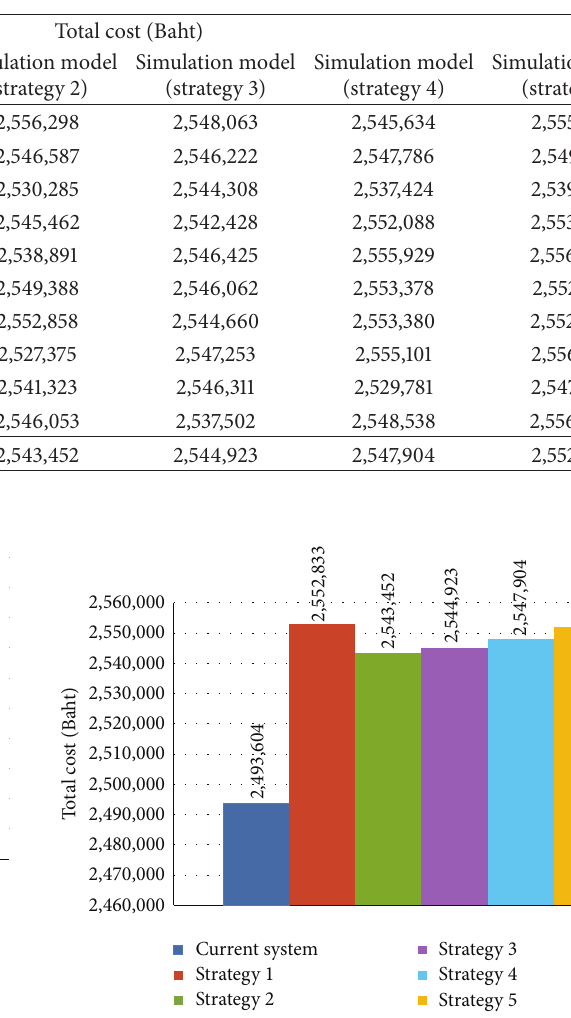
Table 14: Total cost of current system and five strategies.